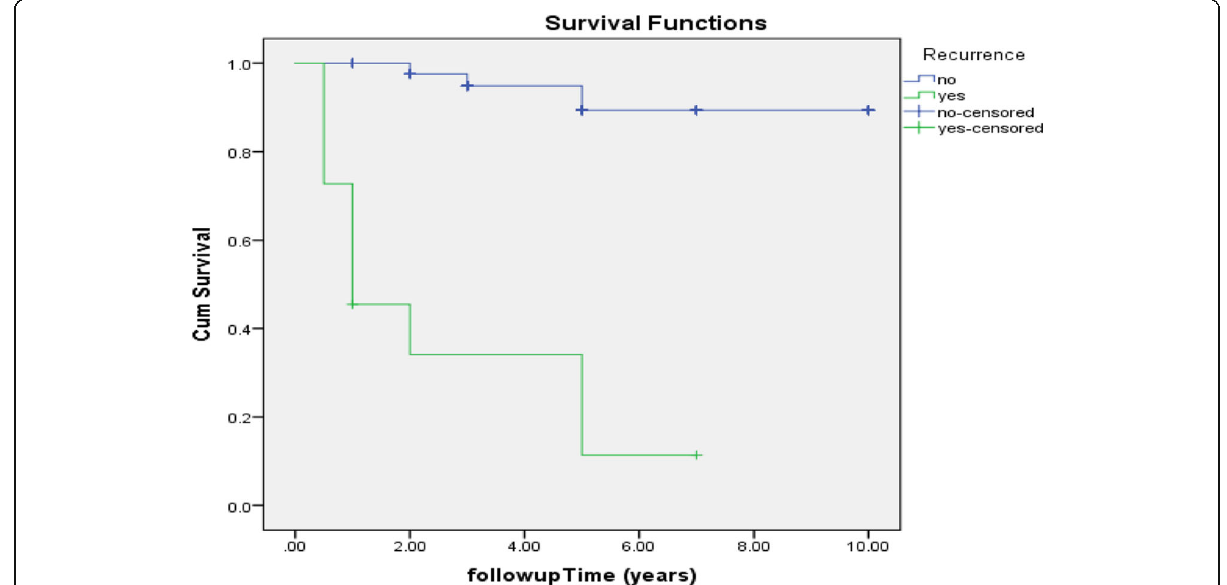
Fig. 4 The cumulative overall survival of patients according to the presence or absence of HCC recurrence